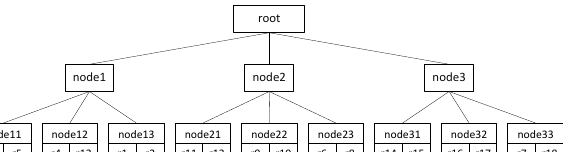
Figure 1. Spatial polygons partition process